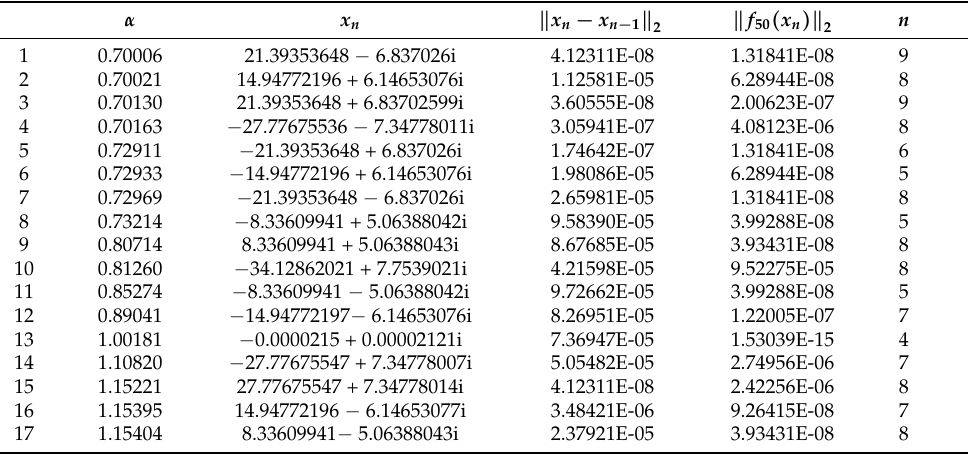
Table 6. Results obtained using the iterative method